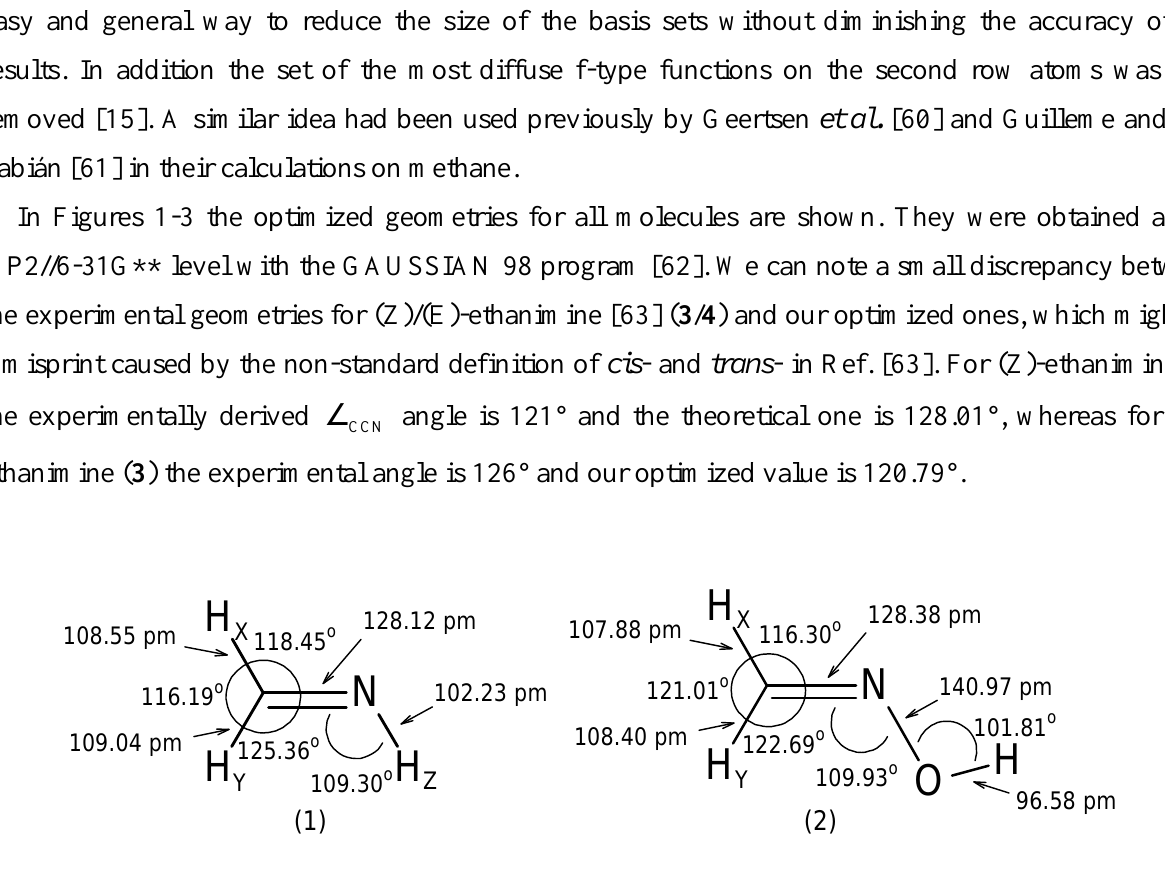
Figure 1. Optimized MP2/6-31G** geometries of methanimine ( 1 ) and methanaloxime ( 2 ).